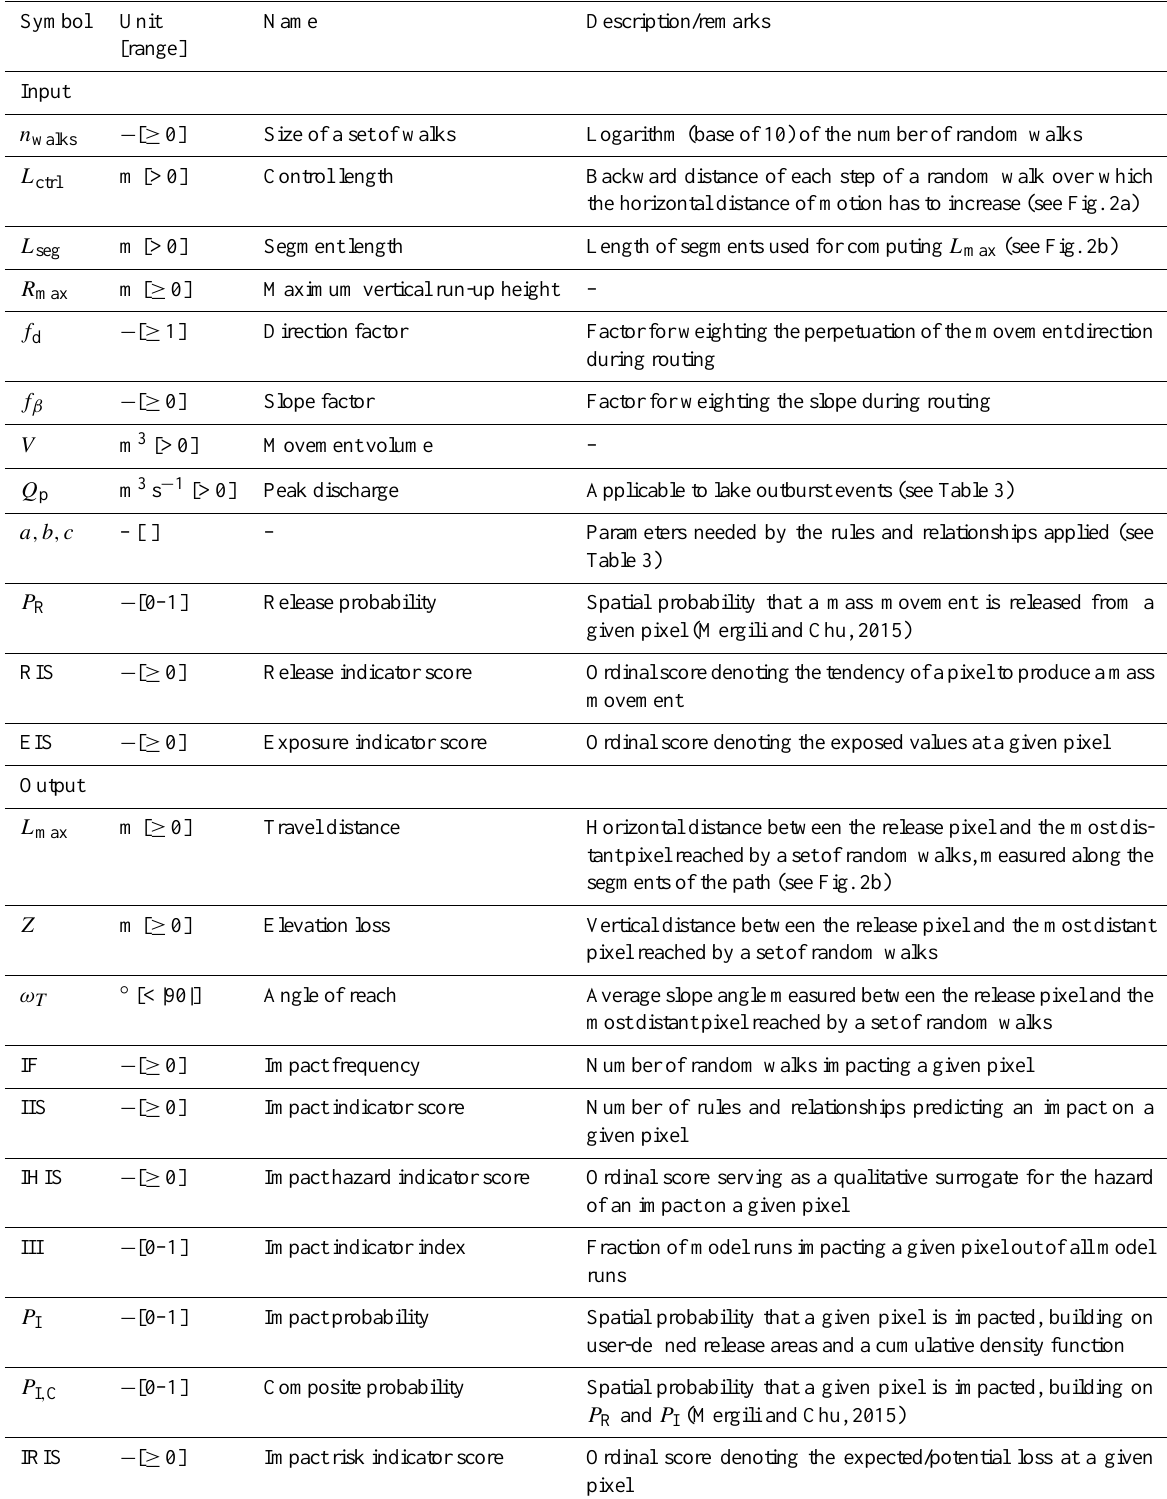
Table 1. Summary of the key variables used in